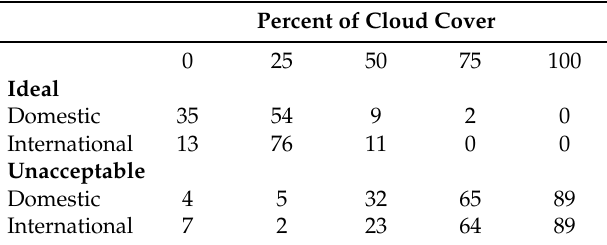
Table 3. Ideal and unacceptable cloud cover (% of